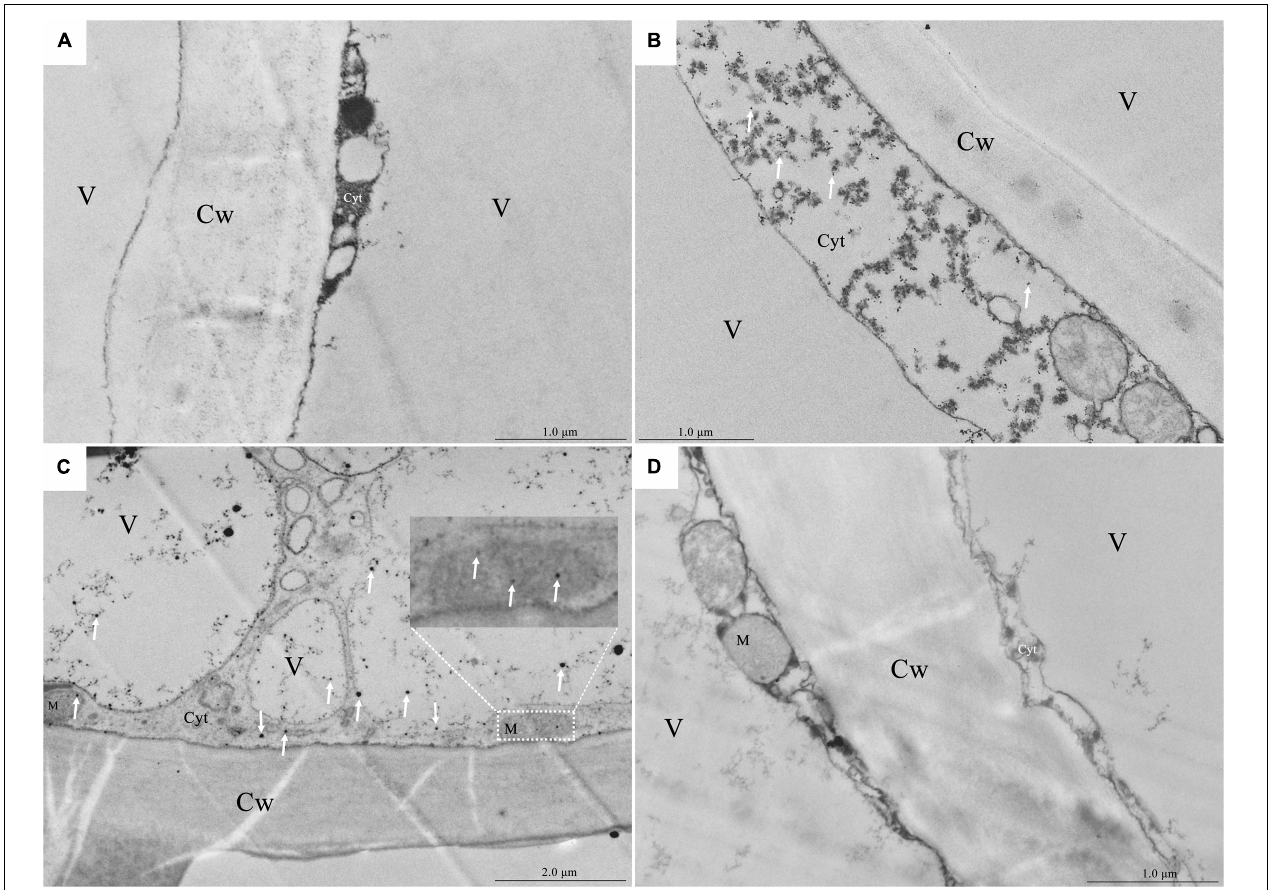
FIGURE 3 | Localization of calcium in the pulp cells via potassium pyroantimonate precipitation. (A) Healthy fruit pulp cell fragments. (B) Pulp cell fragments of the healthy part of the fruit with bitter pit taken from an area close to the bitter pit spot part. (C) Fragments of pulp cells with bitter pit. (D) The ultrathin section of the fragments of pulp cells from apples with the bitter pit was treated with 0.2 mol/L EGTA. The white arrow points to Ca 2 + precipitation. Cw, cell wall; M, mitochondria; Cyt, cytoplasm; V,